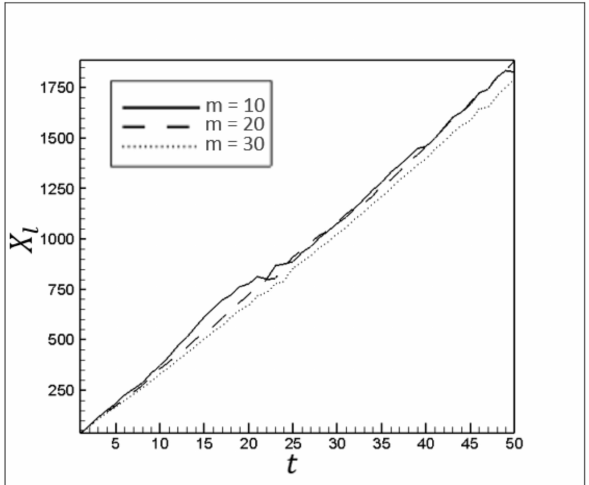
Figure 23. The location of the attacking front over time for different